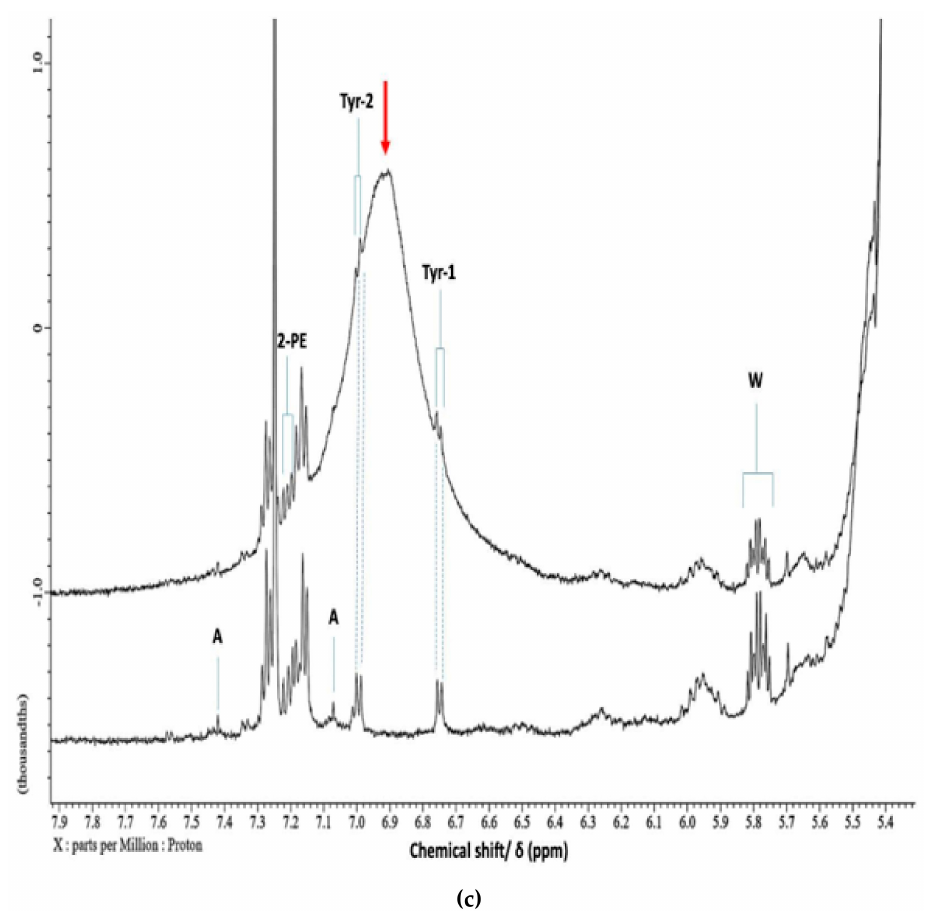
Figure1. 1 HNMRDetectionofCollagenousAgentsinFermentedCLOProduct4. 1 HNMRdetection of collagenous peptides / polypeptides in fermented CLO product. ( a ) Expanded 6.20–9.40 ppm region of 500 MHz 1 H NMR profiles acquired on Products 1–4, showing the unusual, very broad resonance detectable in that of Product 4 only; ( b ) Expanded 8.40–10.30 ppm region of the 500 MHz 1 H NMR spectrum of Product 4 in C 2 HCl 3 solution acquired prior (top, red) and subsequent to (bottom, blue) micro-extraction with 2 H 2 O (bottom). ( c ) Expanded 5.30–7.90 ppm region of the 600 MHz 1 H NMR spectrum of Product 4 in C 2 HCl 3 solution before (top) and after (bottom) treatment with a 10 µ L volume of 2 H 2 O (bottom). The right-hand side panel of ( a ) shows partial spectra containing the tetramethylsilance (TMS) internal chemical shift reference resonance. Abbreviations: 2-PE, 2-phenylethylamine aromatic proton resonances (centered at δ = 7.23 ppm) [31]; Tyr, tyramine aromatic ring proton resonances; A, residual CHCl 3 13 C satellites ( J = 209 Hz); BH, di- tertiary -butyl-hydroquinone (DTBHQ) 3,6-position aromatic proton singlet resonance; BQ, 3,6-position aromatic proton singlet of 2,5-ditertiary-butyl-benzoquinone.; F, formic acid HCO 2 H; W, multiplet ( δ = 5.74-5.86 ppm) of the -CH = CH 2 proton of unsaturated ω -1